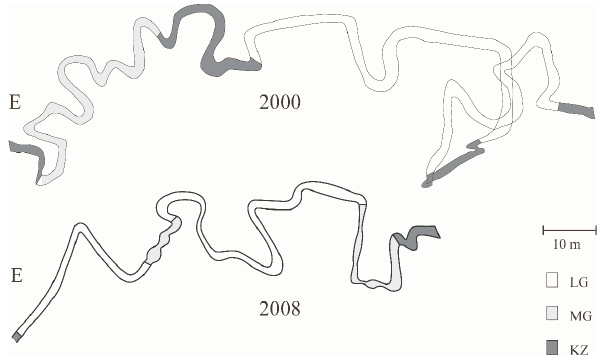
Figure 6. Schematics of englacial channel planform for 2000 and 2008, shaded to indicate the proportions of the channel classed as low gradient (LG), medium gradient (MG), and knickzone (KZ). E denotes the entrance to the